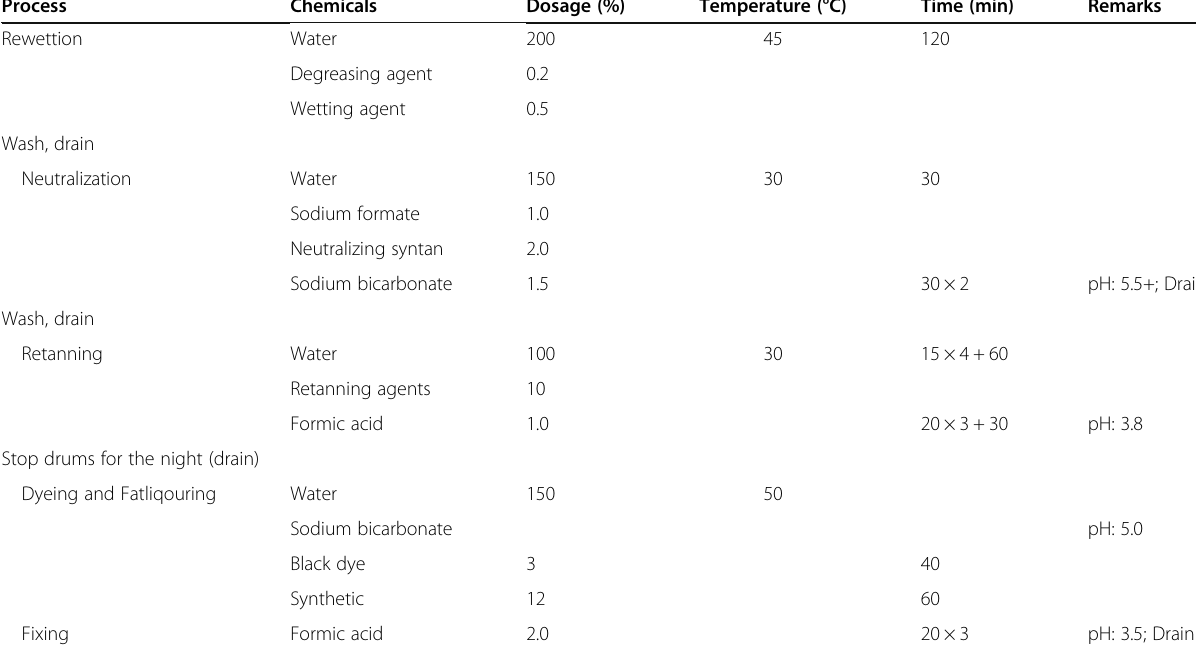
Table 1 Specific operation of conventional and experimental processes a Process